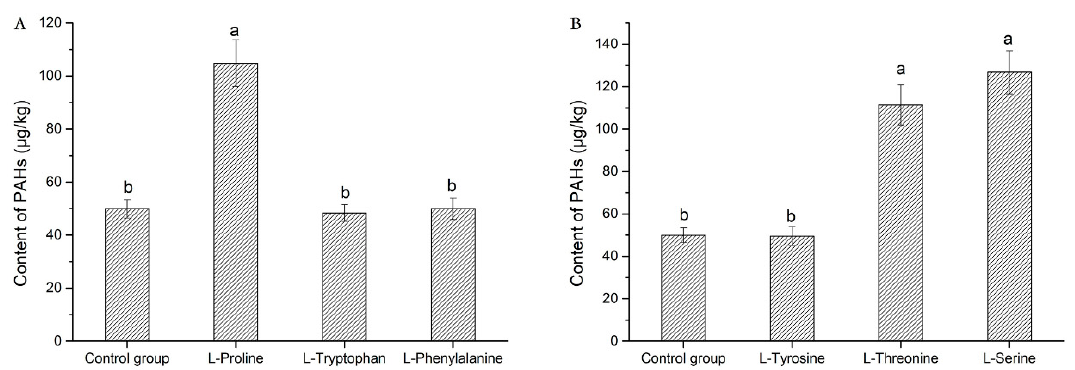
Figure 2. Effect of benzene ring in amino acid on polycyclic aromatic hydrocarbons (PAHs) content. ( A ) The effects of three non-polar amino acids on the content of PAHs in grilled pork sausages; ( B ) The effects of three polar amino acids on the content of PAHs in grilled pork sausages; a, b, different letters indicate significant differences in PAHs content between any two bar graphs in Figure 2A,B ( p < 0.05).